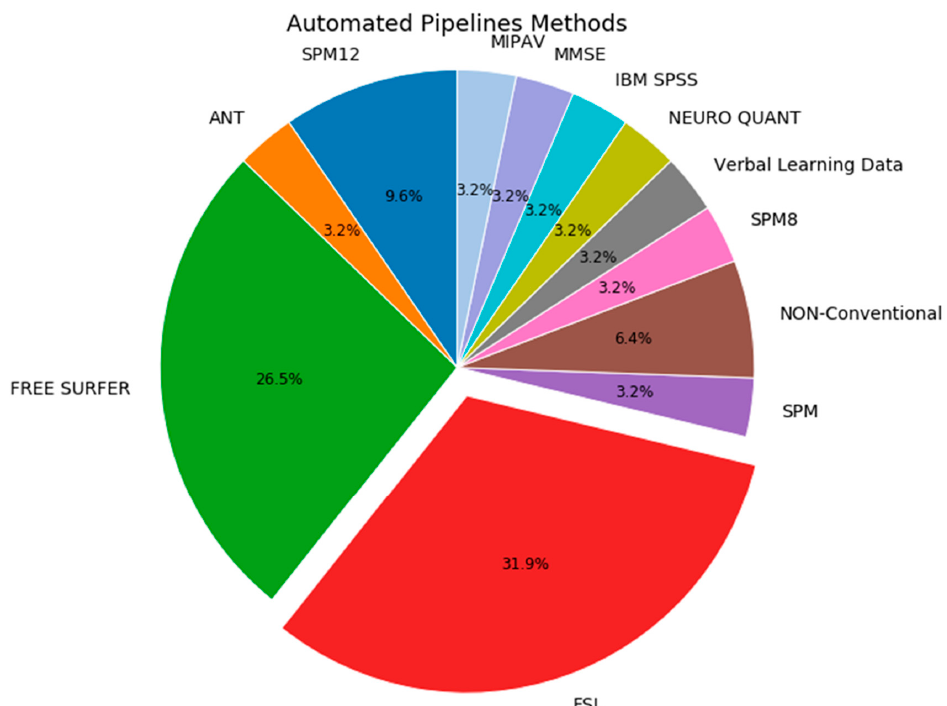
Figure 6. Automatic Pipelines for AD